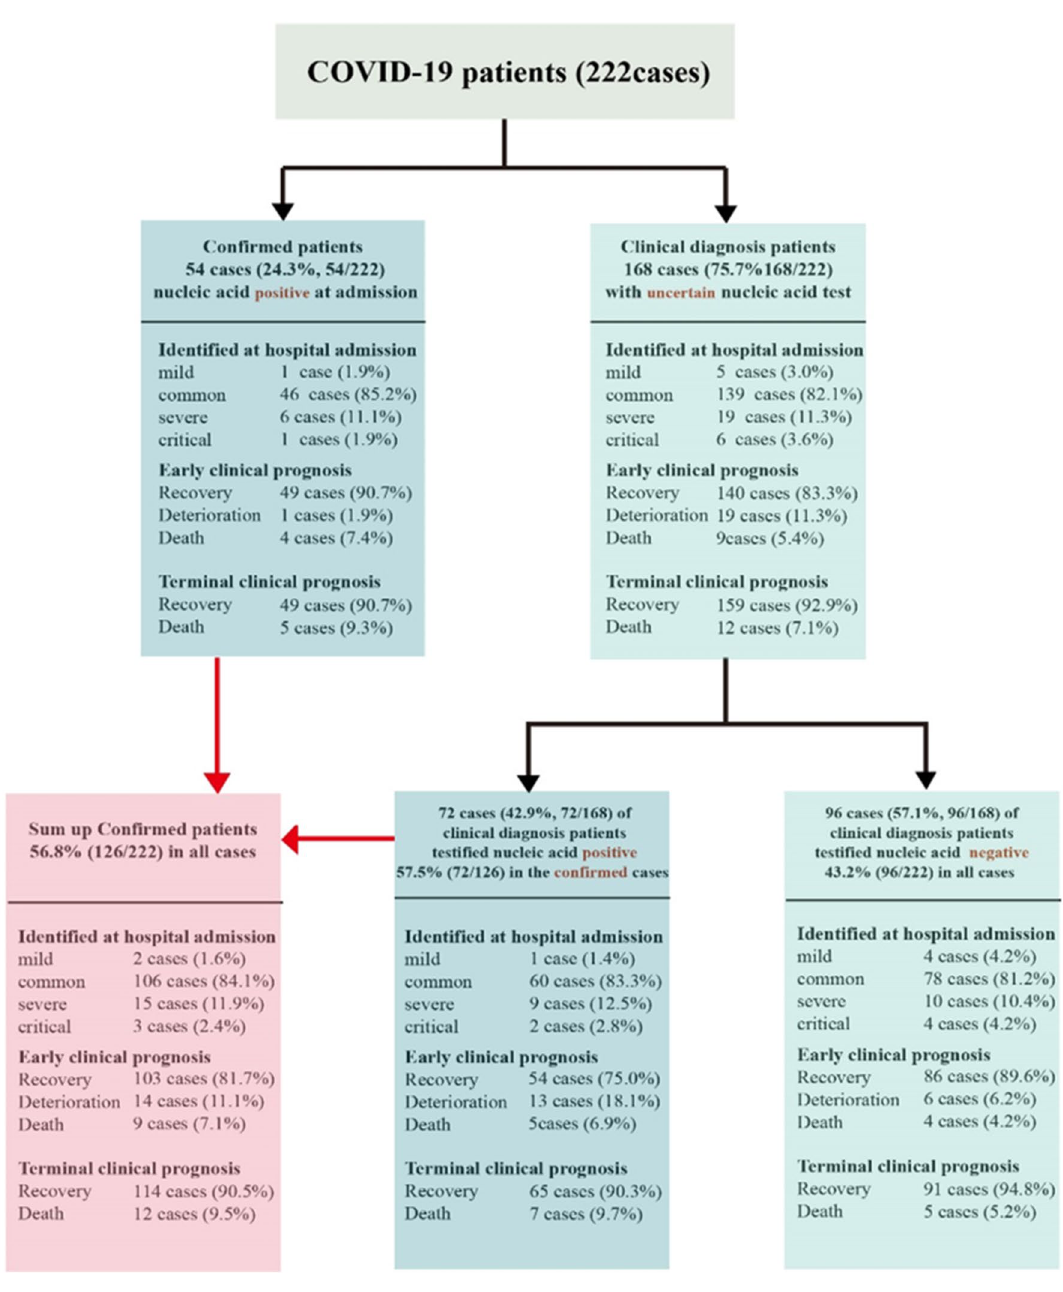
Figure 1. Clinical diagnosis and prognosis of 222